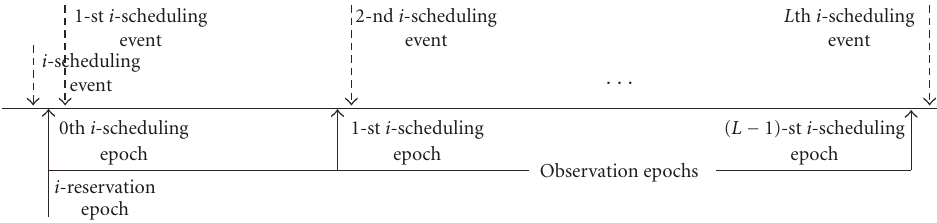
Figure 8: Positions of the observation epochs within a polling